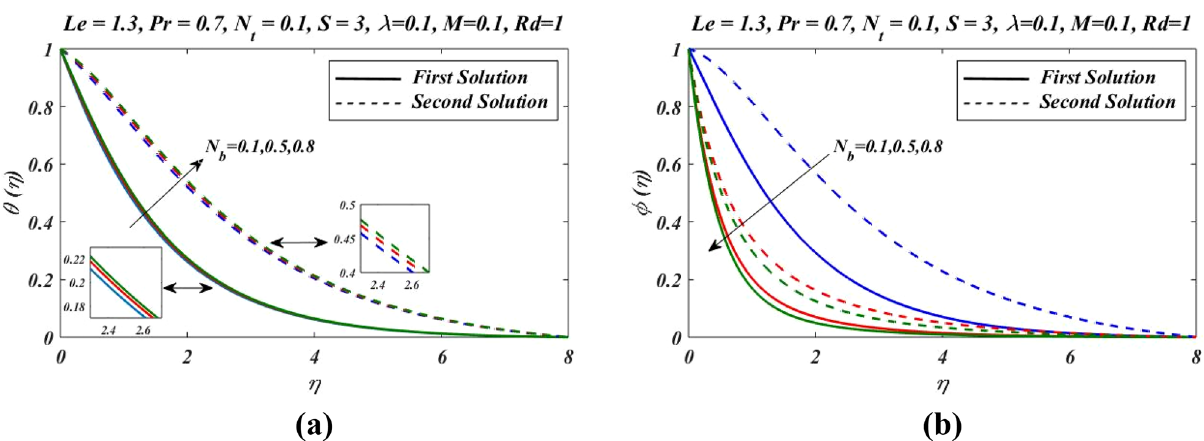
Figure 9. Outcomes of N b on ( a ) temperature and ( b ) nanoparticles volume